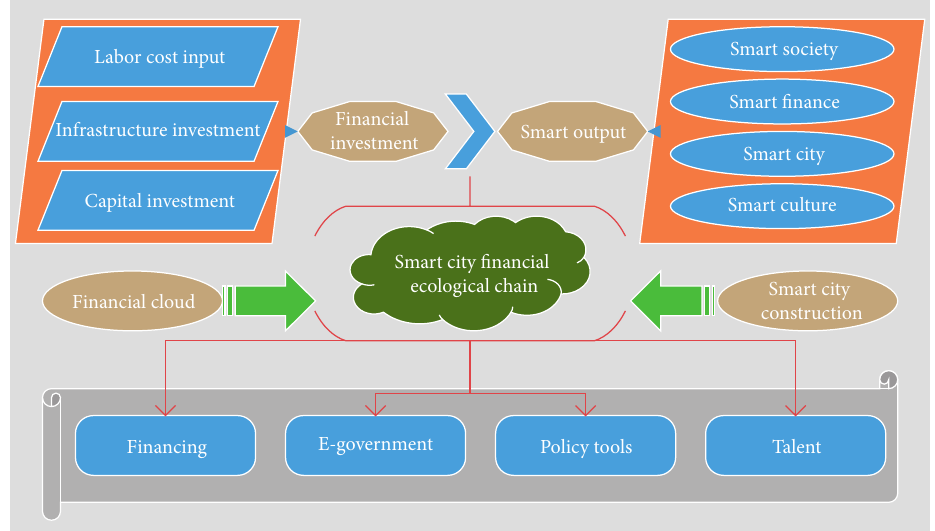
Figure 2: Schematic diagram of smart city financial